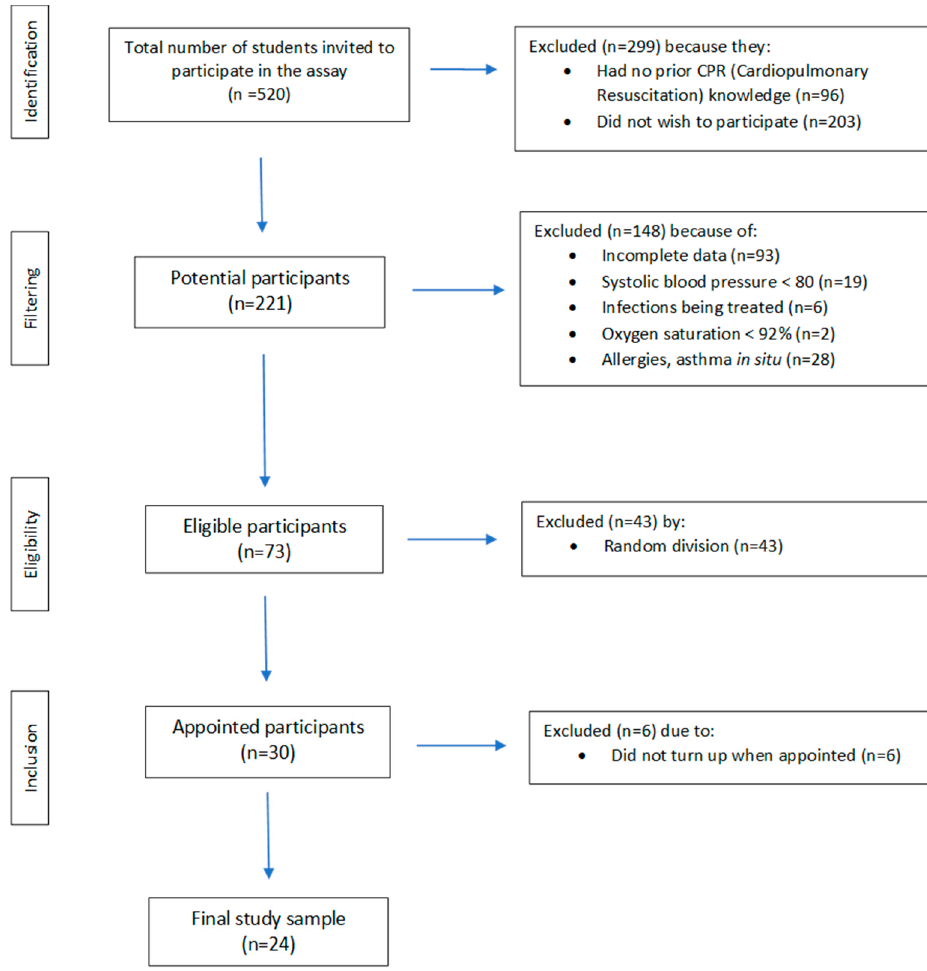
Figure 1. Flow chart of the selection of participants for this